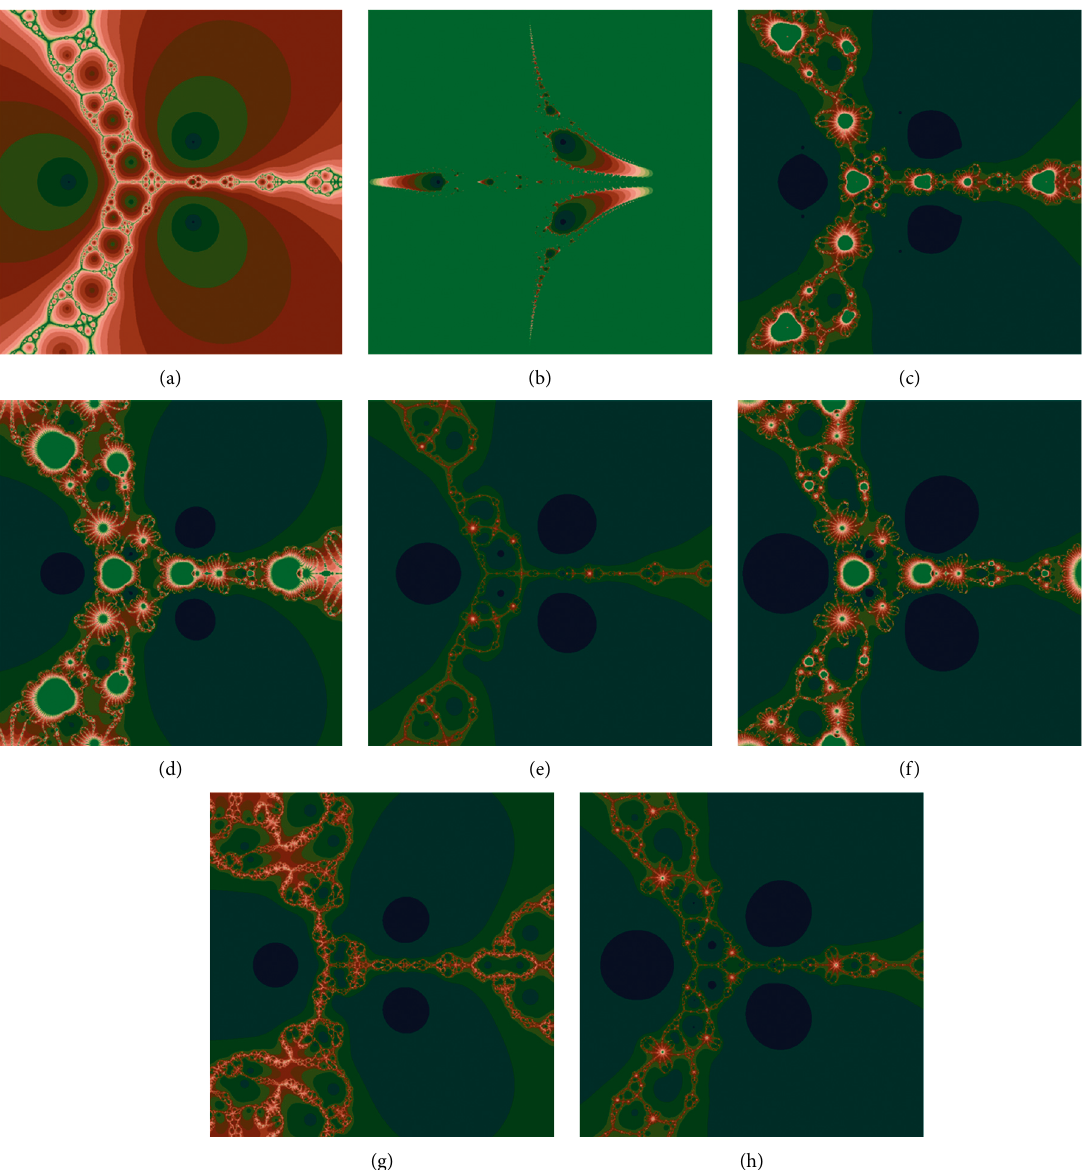
Figure 5: Polynomiographs for q